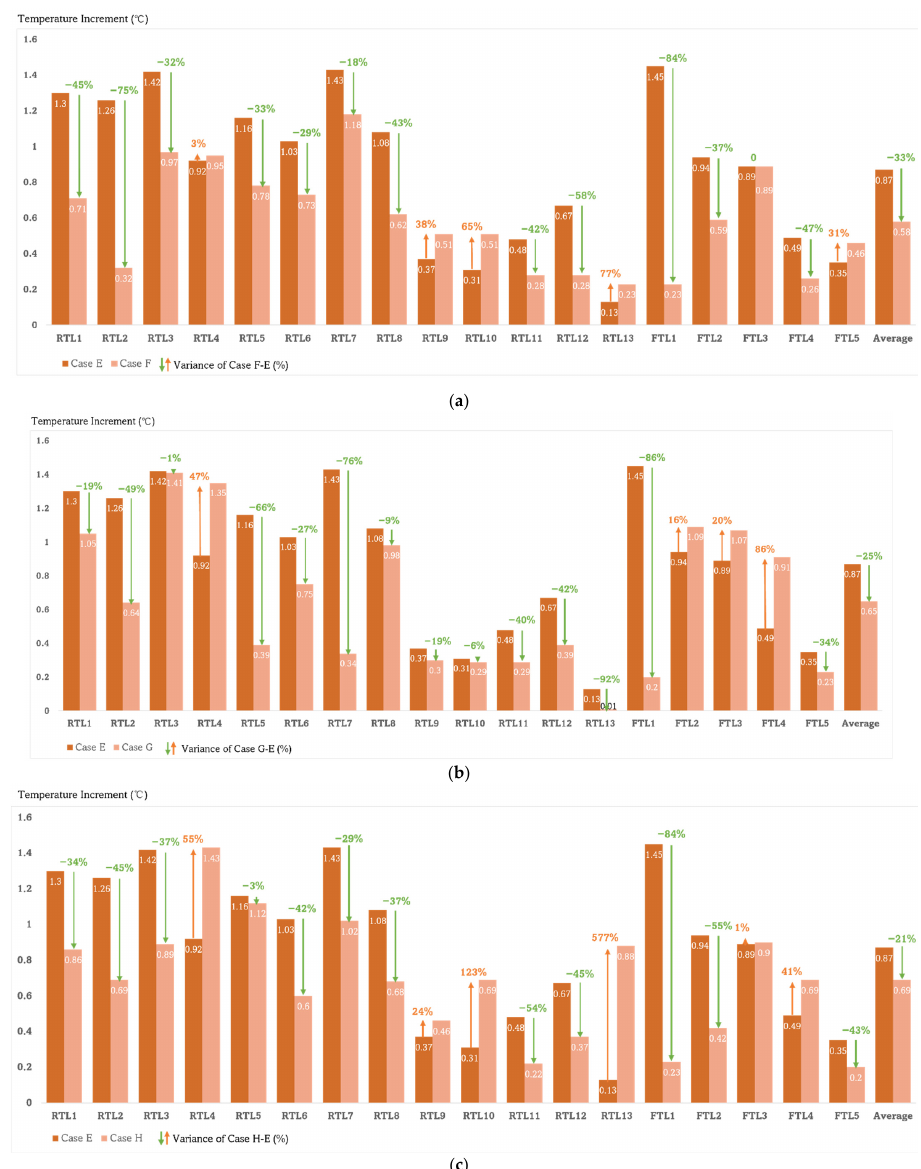
Figure 13. ( a ). Temperature increment of Case F & E and the variance of Case (F–E) % of each test line and the average value, Variance of Case (F–E) was calculated with the equation Case ( F − E ) = T CaseF − T CaseE % ( T CaseF is the temperature increment of each test line in Case D and T CaseE is the temperature increment of each test line in Case E). ( b ). Temperature increment of Case G & E and the variance of Case (G–E) % of each test line and the average value, Variance of Case (G–E) was calculated with the equation Case ( G − E ) = T CaseG − T CaseE % ( T CaseG is the temperature increment of each test line in Case D and T CaseE is the temperature increment of each test line in Case E). ( c ). Tem- perature increment of Case H & E and the variance of Case (H–E) % of each test line and the average value, Variance of Case (H–E) was calculated with the equation Case ( H − E ) = T CaseH − T CaseE % ( T CaseH is the temperature increment of each test line in Case D and T CaseE is the temperature increment of each test line in Case